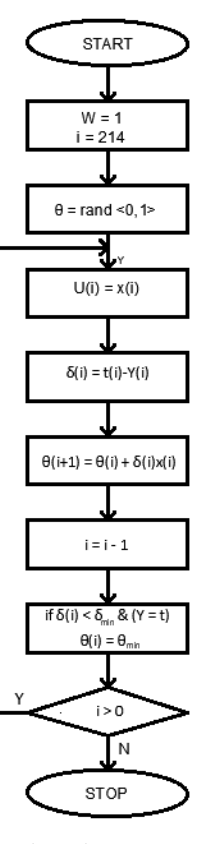
Figure 11. The applied perceptron training algorithm: W —weight, U —perceptron input, t — assumed response vector, Y —perceptron output, θ —bias.